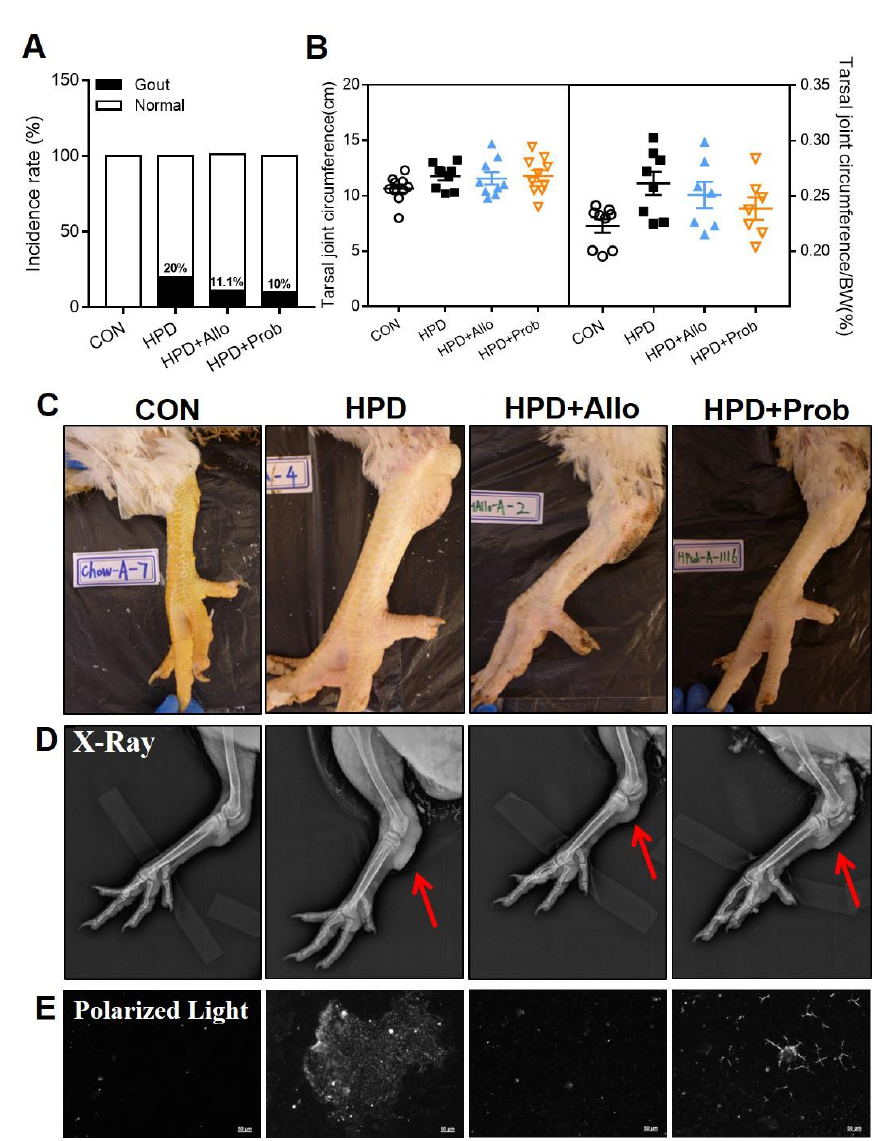
Figure 9. Allopurinol and probenecid treatment decreases gout incidence rate in chickens. ( A ) Gout incidence rate ( n = 8 – 10). ( B ) Tarsal joint circumference and tarsal joint circumference/BW of chicken claws. ( C ) Representative images of chicken claws in 73 days. ( D ) Representative images of chicken claws in X-ray conditions. The red arrows are the position of swell in the joint of chickens. ( E ) Representative images of MSU crystal in synovial fluids of chicken claws using polarized light microscopy (scale: 50 µm). Values are presented as the mean ± SEM.